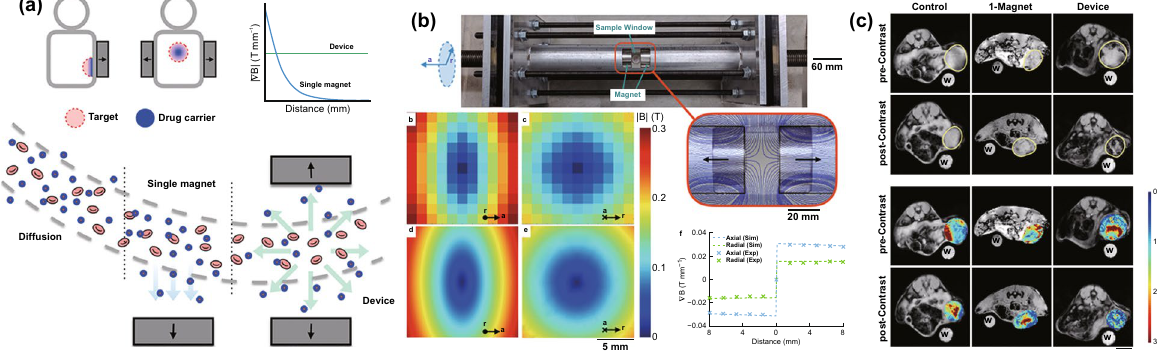
Fig. 9 a Magnetic device, comprising two oppositely polarized magnets, enhances magnetic drug targeting in deep tissues. b Magnetic device contains a sharp zero point surrounded by constant field gradients. c Pre- and postcontrast images have similar signal distributions in the control. However, mice that have been exposed to the device show much less T2 signal (hypointensity) postcontrast. Water control labeled “w”. Scale bar = 5 mm. Reproduced with permission from Ref.